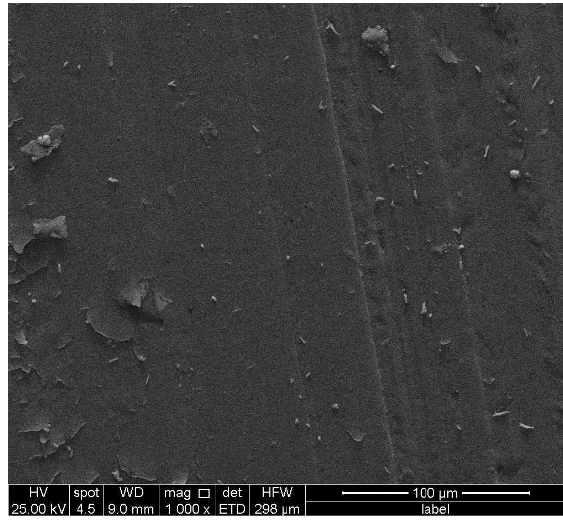
Figure 13. SEM image of the worn surface for the PEEK disc against the SN0 pin at the speed of 1.73 m/s. In summary, the incorporation of hBN into a silicon nitride matrix reduced the me- chanical properties, but provided conditions for the formation of a tribofilm. When the content of hexagonal boron nitride was in the range of 5% to 20%, the friction caused by mechanical meshing could be weakened by the formation of the tribofilm. As the speed increased, more wear debris was taken away from the wear interface, and the tribofilm was more continuously formed on the wear surface. So, the sliding pairs presented lower and lower friction and wear with the increase in speed. When the hBN content reached 30%, severe deterioration of the mechanical properties caused an extremely rough wear surface with more serious mechanical wear. Once the speed increased, the mechanical wear became more severe under the action of shear force. Hence, the friction coefficient and wear rate of the SN30/PEEK pair increased with the increase in the sliding speed. When the SN0 pin slid against the PEEK disc, no tribofilm formed on the worn surface, and the main source of friction force came from mechanical meshing. Meanwhile, the increase in speed aggravated the frequent plowing and mechanical meshing, resulting in a greater friction coefficient and a higher wear